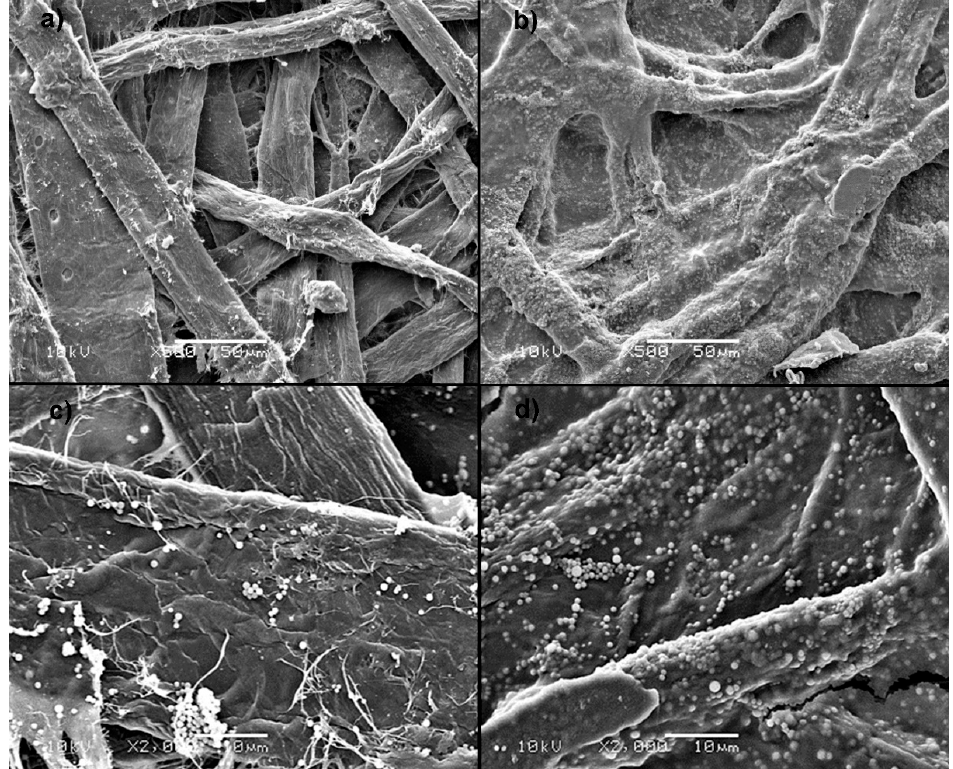
Figure 8. SEM of handsheet samples: ( a ) reference, uncoated, ( b ) first cycle coated, ( c ) 4th cycle uncoated, ( d ) 4th cycle coated.